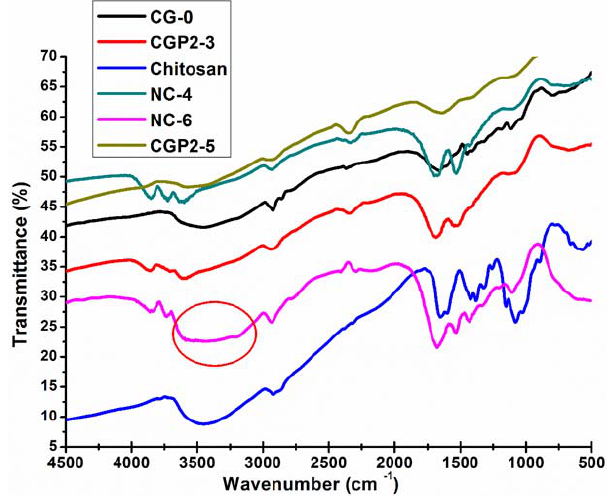
Figure 2. FT ‐ IR spectra of pure chitosan, CG ‐ 0, CGP2 ‐ 3, CGP2 ‐ 5, NC ‐ 4, and NC ‐ 6